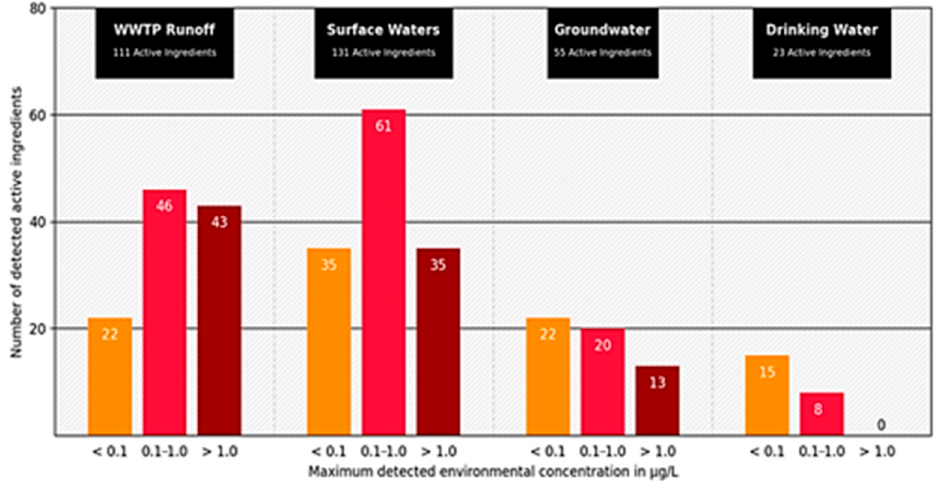
Figure 2. Number of active pharmaceutical ingredients measured in wastewater treatment plant effluents (111 active ingredients), surface (131 active ingredients), ground (55 active ingredients), and drinking water (23 active ingredients). Displayed according to concentration classes (< 0.1 μ g; 0.1–1.0 μ g; > 1.0 μ g) of the maximum measured concentration (modified according to